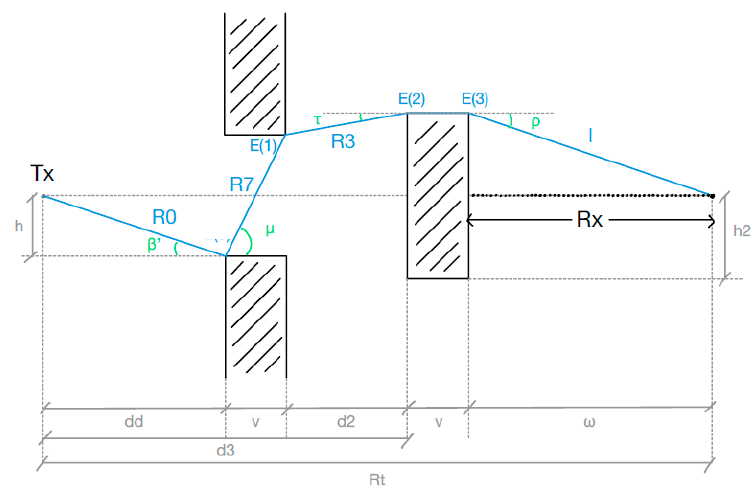
Figure 26. Fifth quadruple diffraction (Edif_q5) of the second considered NLOS scenario.